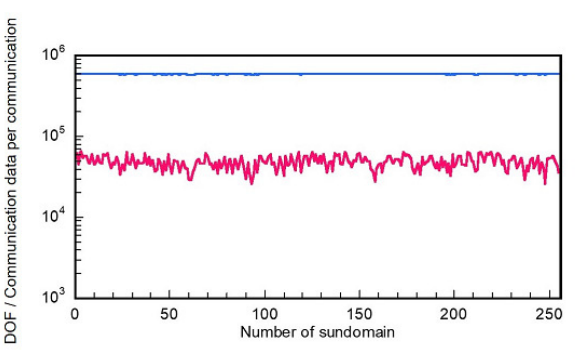
Figure 11. Distribution of workload on each subdomain. Blue line: DOF; Pink line: number of communication data per